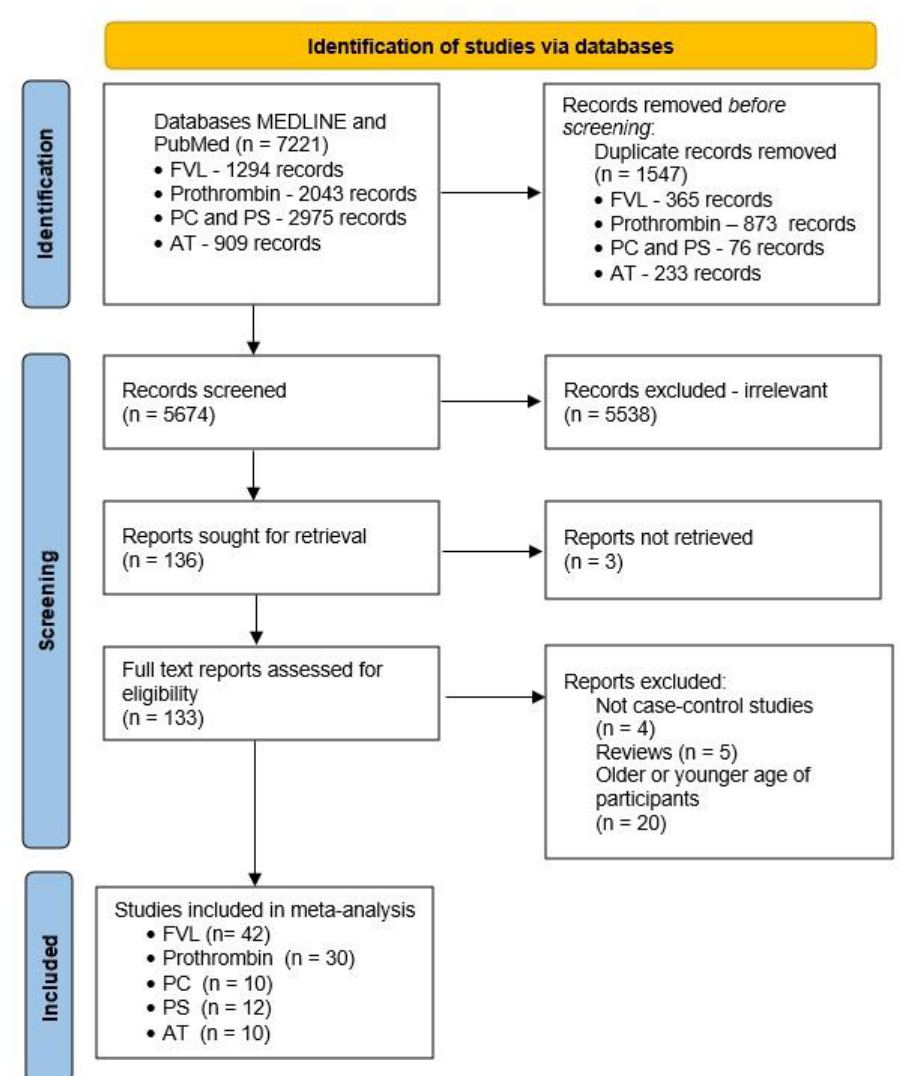
Figure 1. Flow diagram of the process of selecting eligible articles for inclusion in the study.